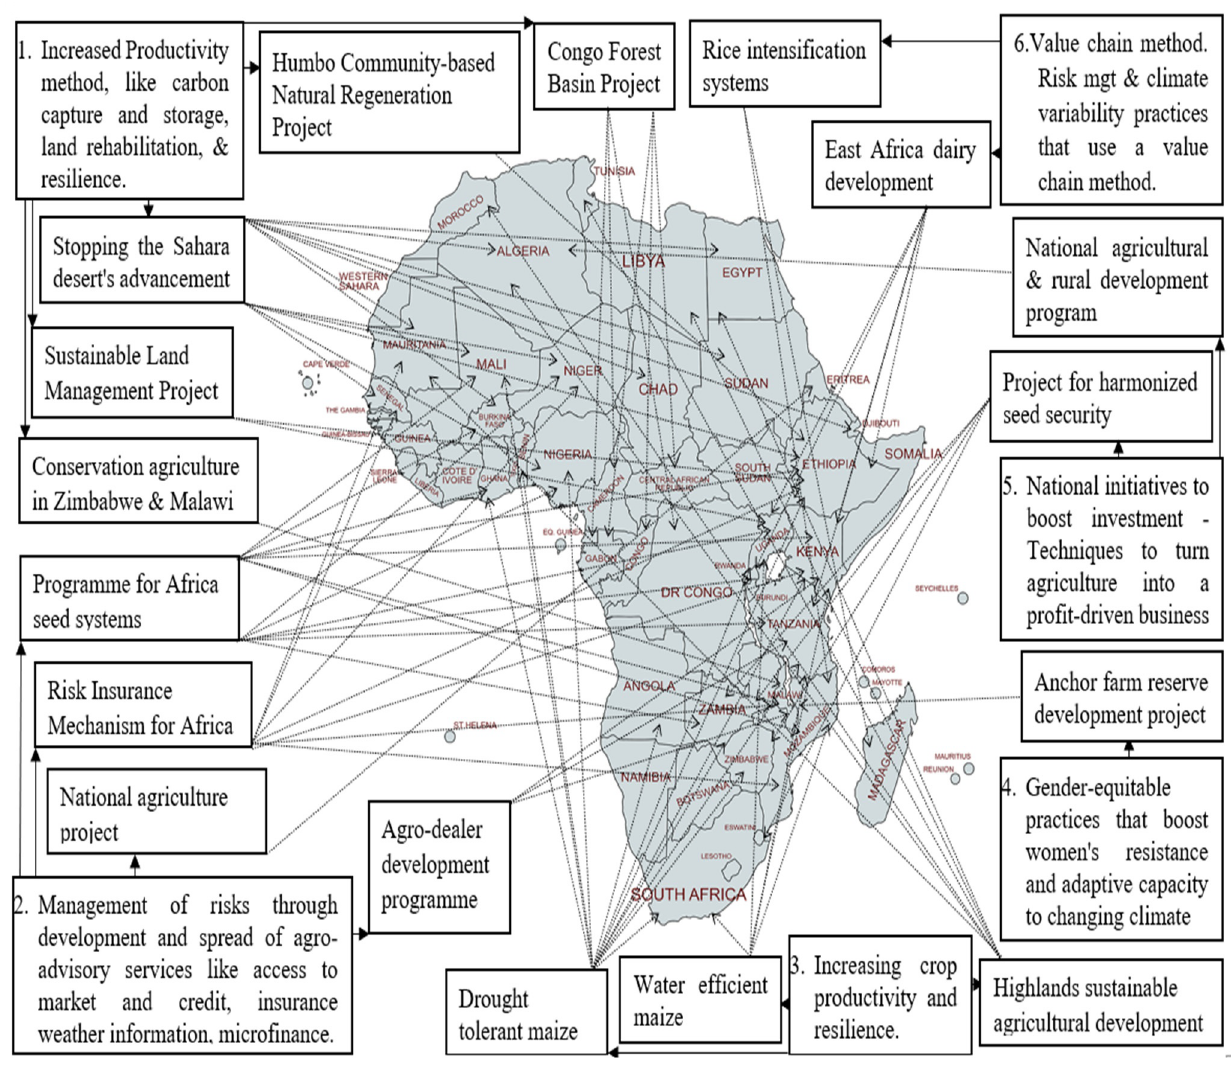
Figure 1. Selected successful CSA-CCAP methods across Africa.